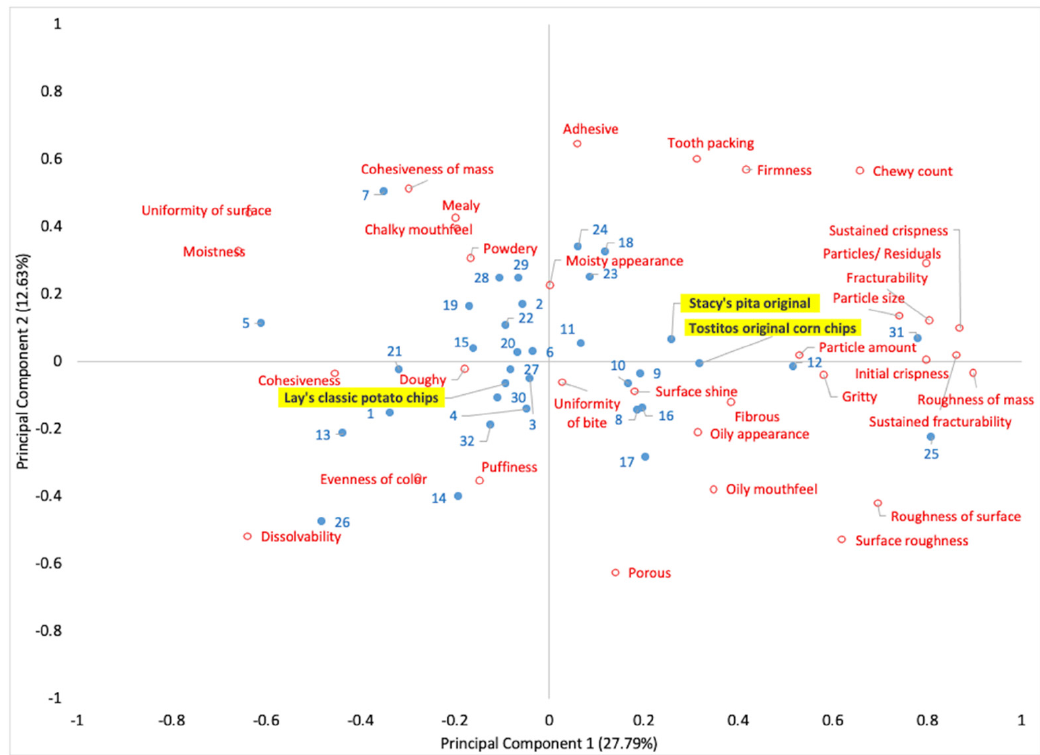
Figure 4. PCA plot representing the descriptive texture profiling results of SK snacks. The numbers (including dots) highlighted with blue color represent the snack type as listed in Table 2, and the text (including dots) in red color denotes texture attributes. Three US snacks—Stacy’s pita original, Lay’s classic potato chips, and Tostitos original corn chips (highlighted in yellow color)—were used to compare texture dimensions with SK